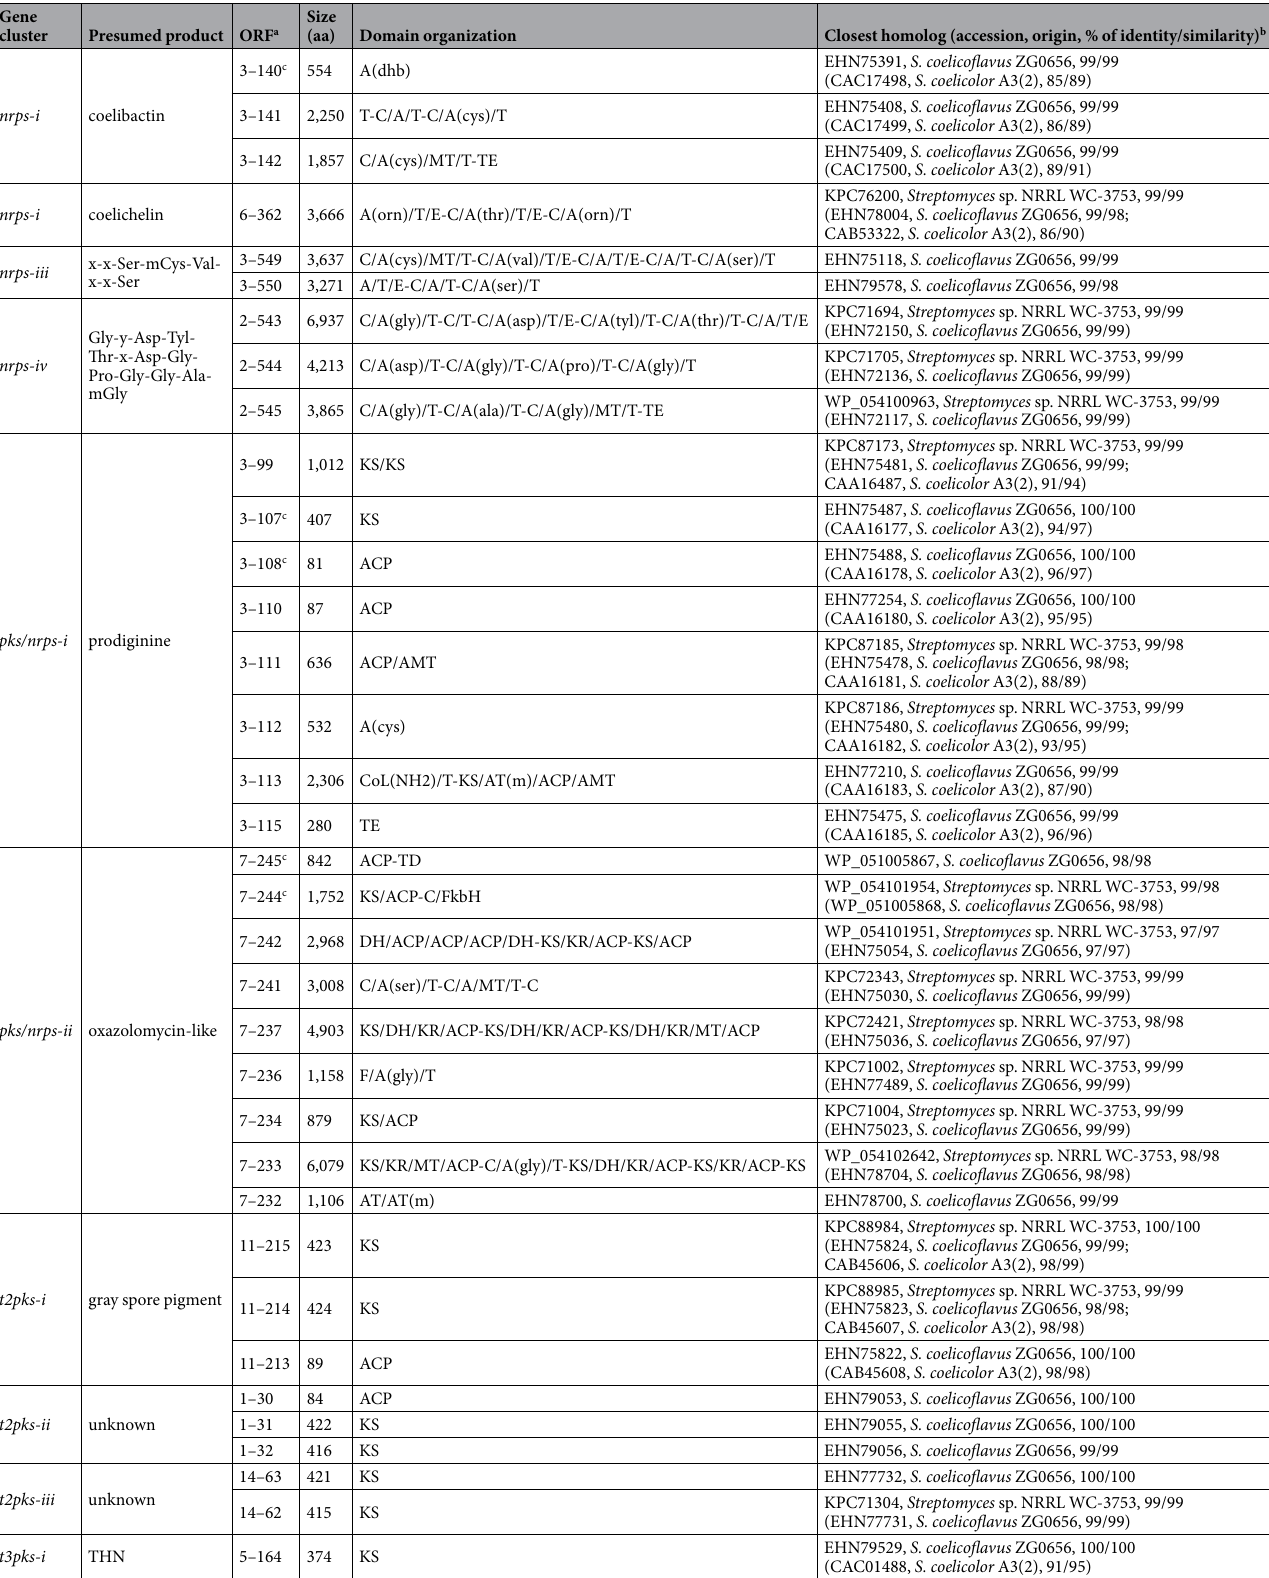
Table 5. ORFs encoding NRPSs and PKSs in NRPS and PKS gene clusters of S. coelicoflavus NBRC 15399 T . Abbreviations are the same as those of Table 2. a ORFs are shown as a combination of scaffold number and ORF number. b If the homolog in S. coelicoflavus ZG0656 is not the closest and/or Streptomyces coelicolor A3(2) harbors the homolog, it is shown in parentheses. c Encoded on the complementary